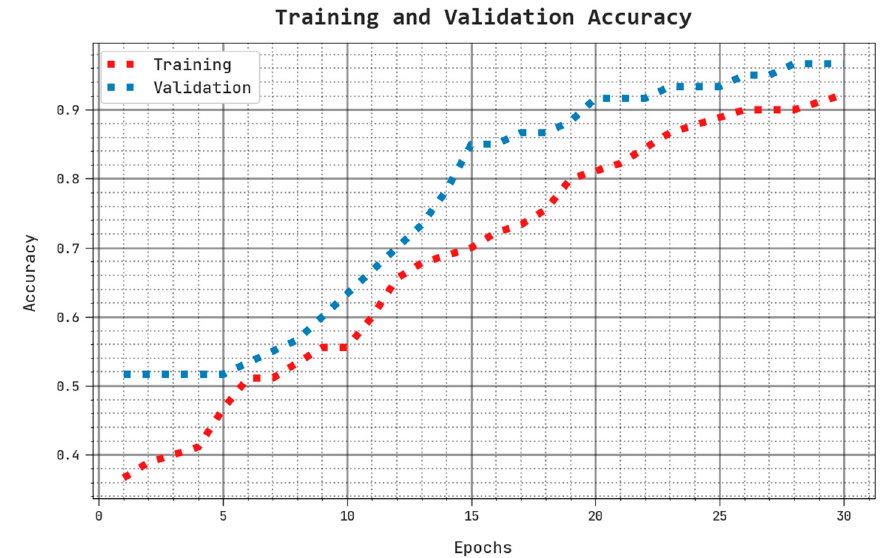
Figure 8. TACC and VACC analysis of AHBATL-MNC approach.